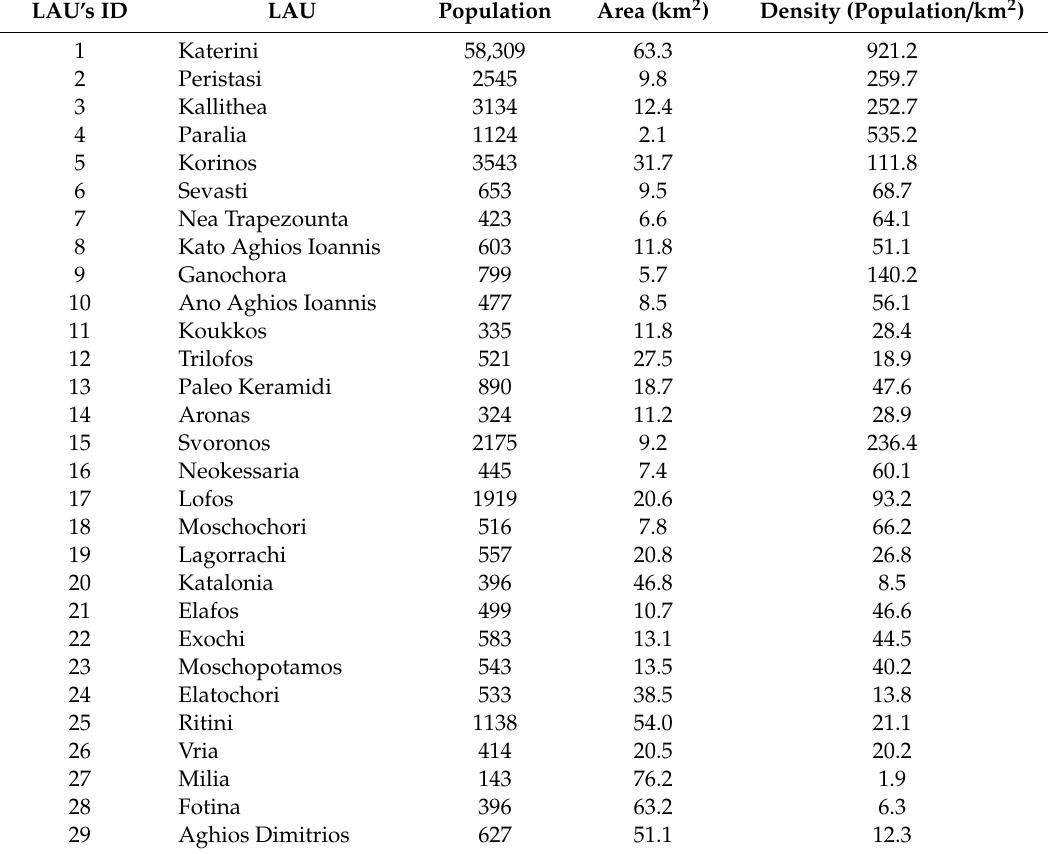
Table 1. Population, area and density by LAU, 2011.